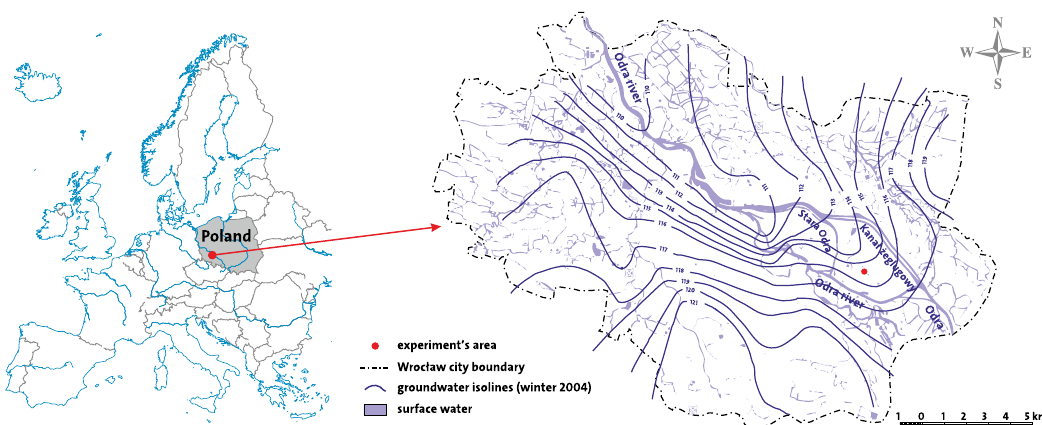
Figure 2. Location of the experiment’s area. (latitude: 51 ◦ 6 (cid:48) 19.3 (cid:48)(cid:48) N longitude: 17 ◦ 5 (cid:48) 20.7 (cid:48)(cid:48) E altitude: 116.3 m a.s.l.).